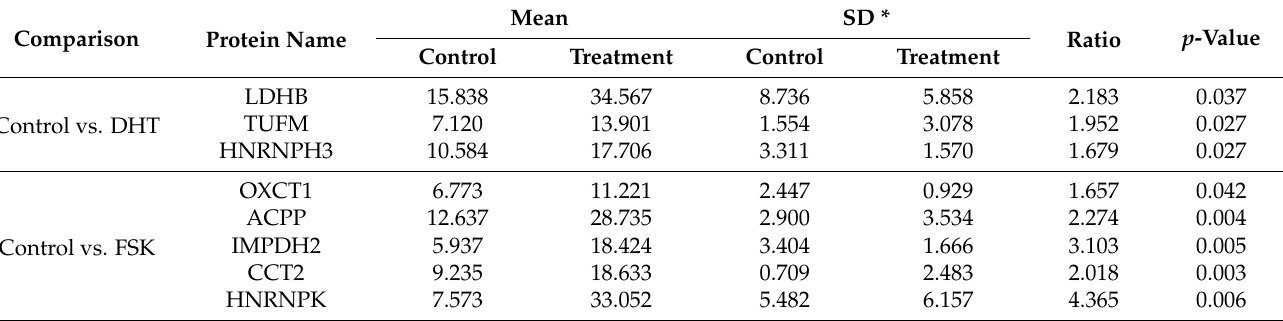
Table 1. The average density values of proteins that showed significant changes in expression in response to DHT or FSK.